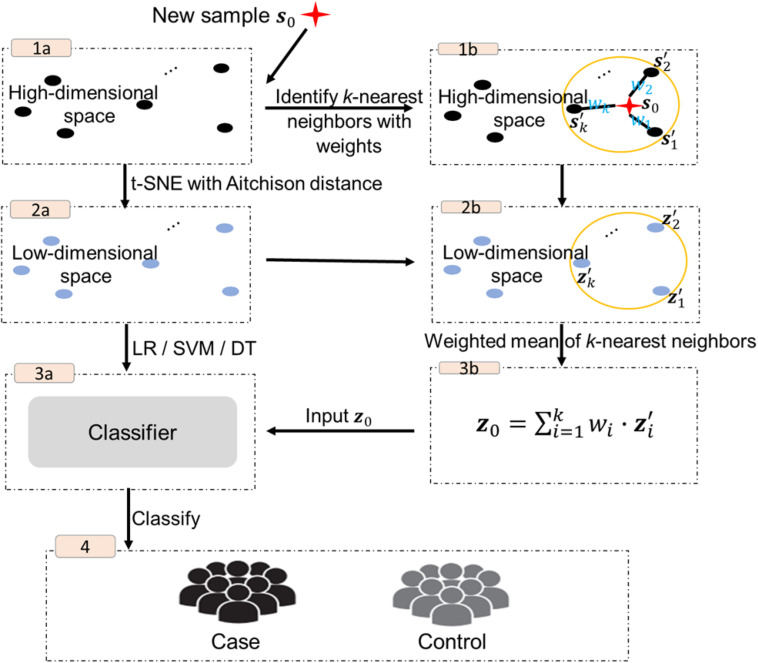
Overview of the procedure of our approach.